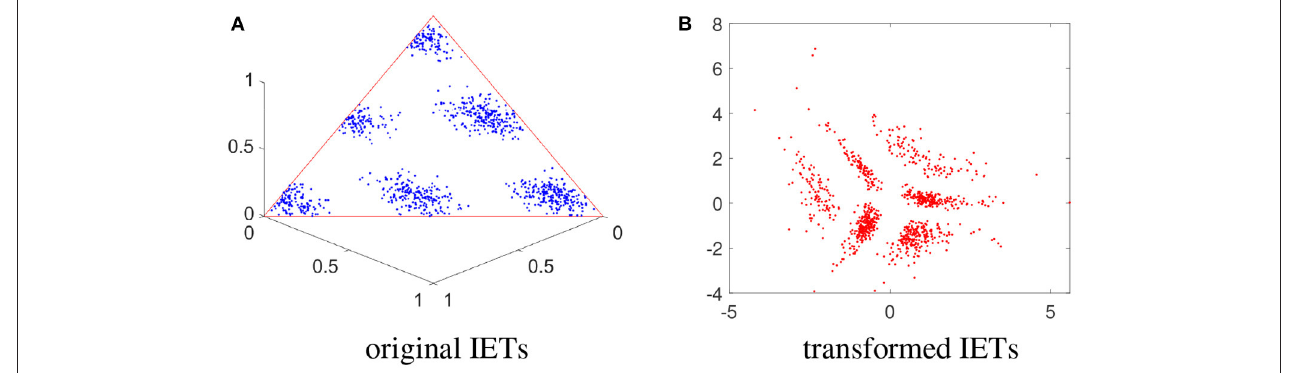
FIGURE 3 | 2-event IETs on simplex and transformed IETs on Euclidean space. (A) Scatter plot for the original IETs on the 3-D simplex. (B) Transformed IETs after ilr transformation in the 2-D Euclidean space.